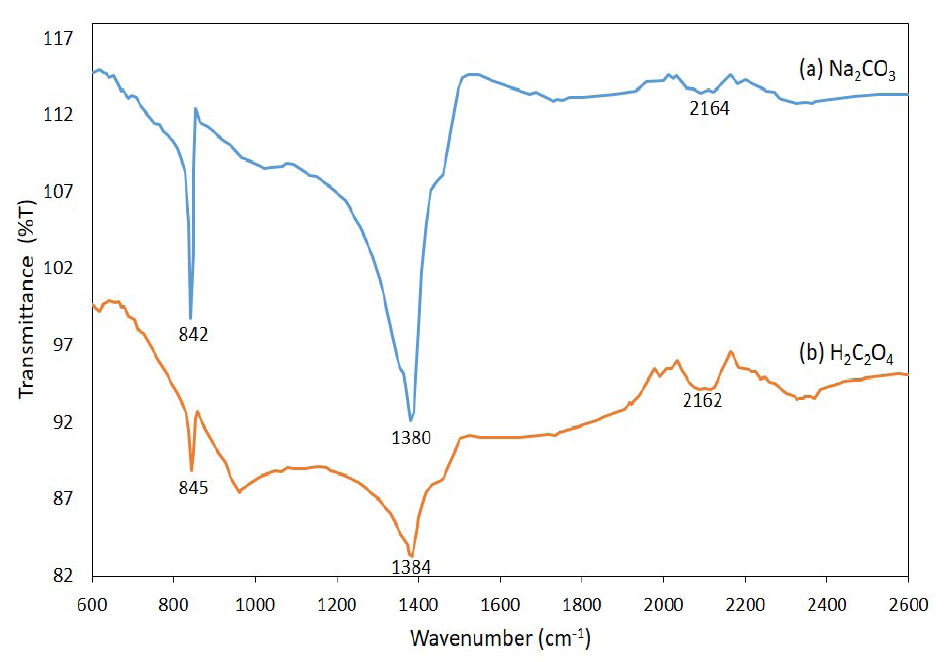
O synthesized using (a) H 2 3